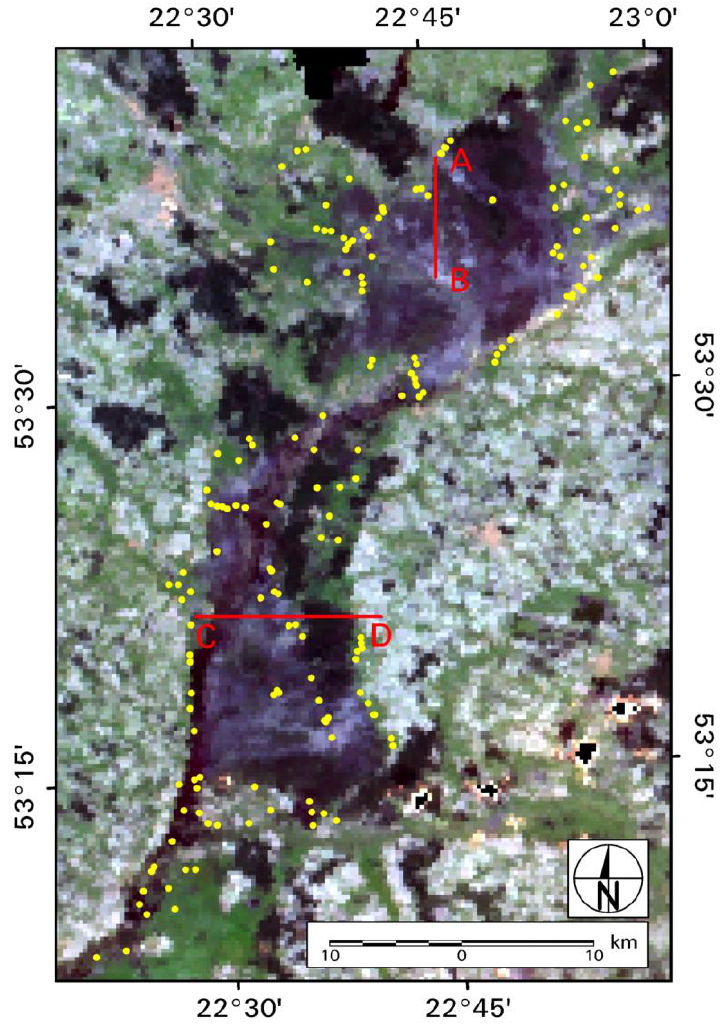
Figure 1. Test site on MERIS RGB (7, 5, 2) composition with transects A–B and C–D marked by the red line for which chosen AVHRR data have been transformed into T MERIS data into NDVI